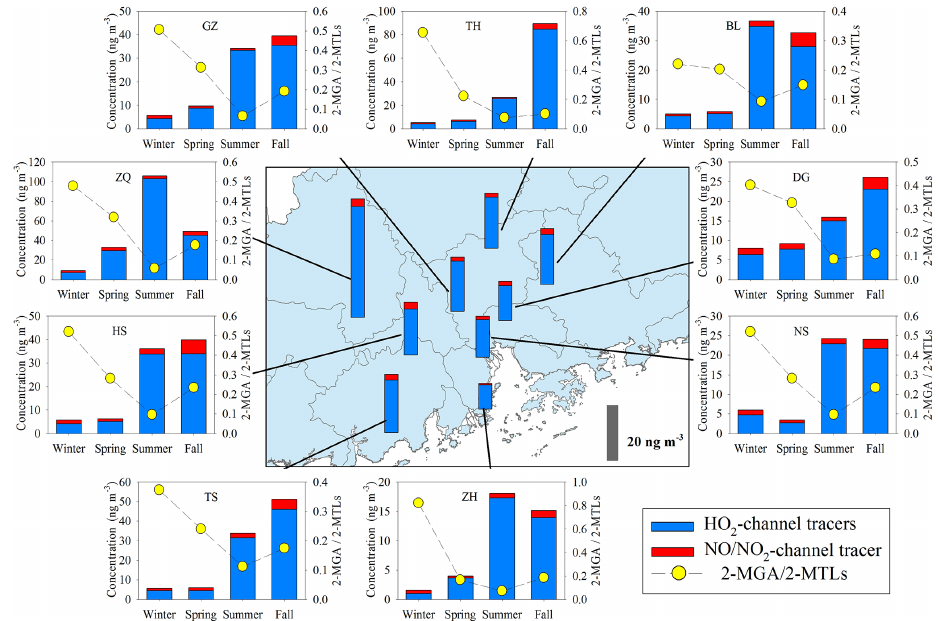
Figure 6. Spatial and seasonal variations of SOA I tracers at nine sites in the PRD. The bars in the central panel represent the annual average concentrations of the SOA I tracers.